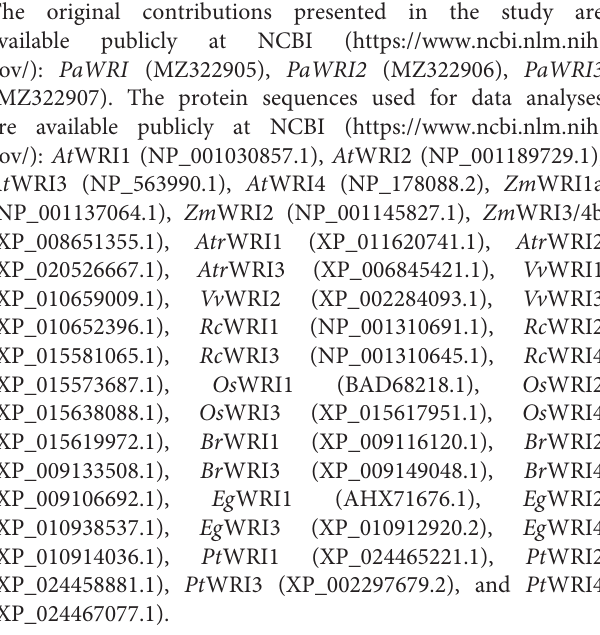
Frontiers in Plant Science |